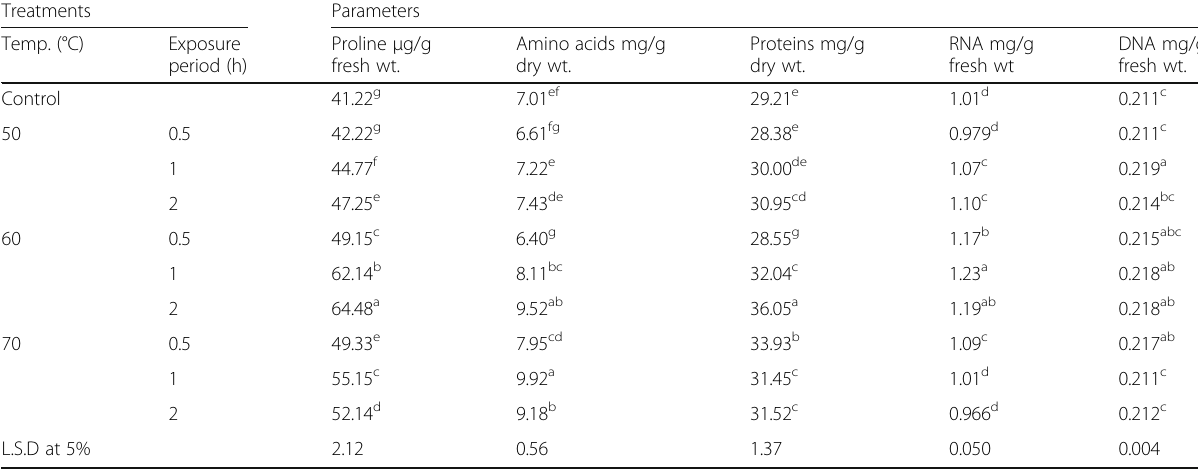
Table 6 Effect of seed hardening on proline, free amino acids, RNA, and DNA content of plant shoots Treatments Parameters Temp.